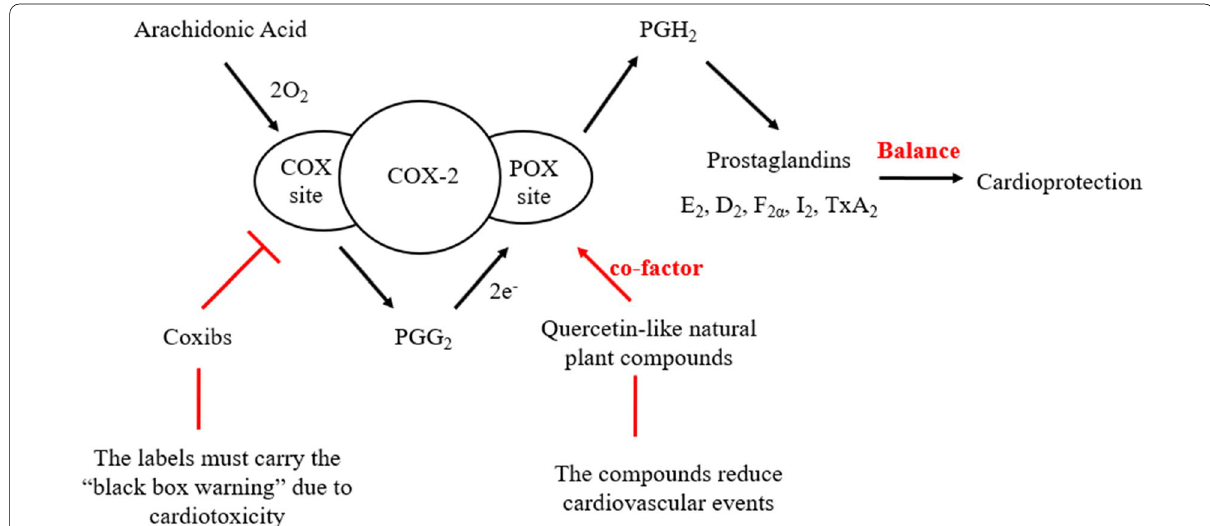
Fig. 1 COX and POX reactions are catalyzed by coxibs and quercetin-like natural plant compounds, respectively. COX-2 catalyzes arachidonic acid conversion to